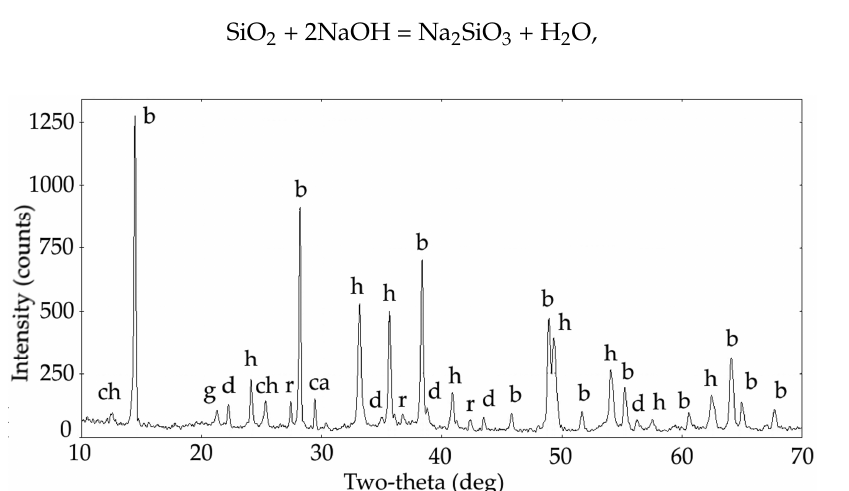
Figure 1. The X-ray diffraction (XRD) pattern of the Middle-Timan bauxite, where: b, boehmite; h, hematite; g, gibbsite; d, diaspore; ca, calcite; r, rutile; and ch, chamosite.